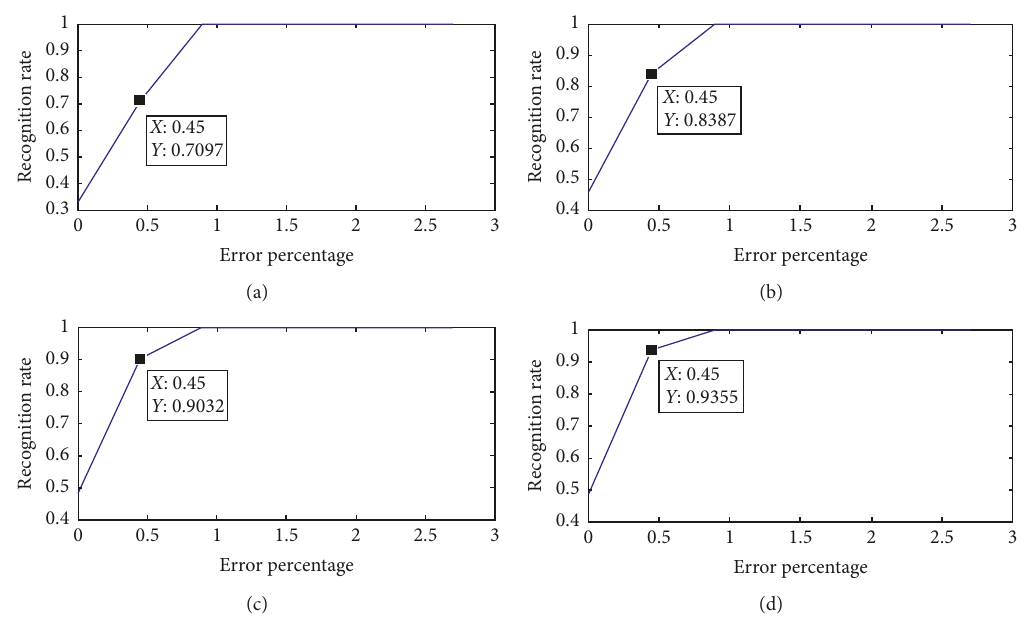
Figure 14: Identification results of broken wires under different decision trees. (a) 10. (b) 20. (c) 40. (d)